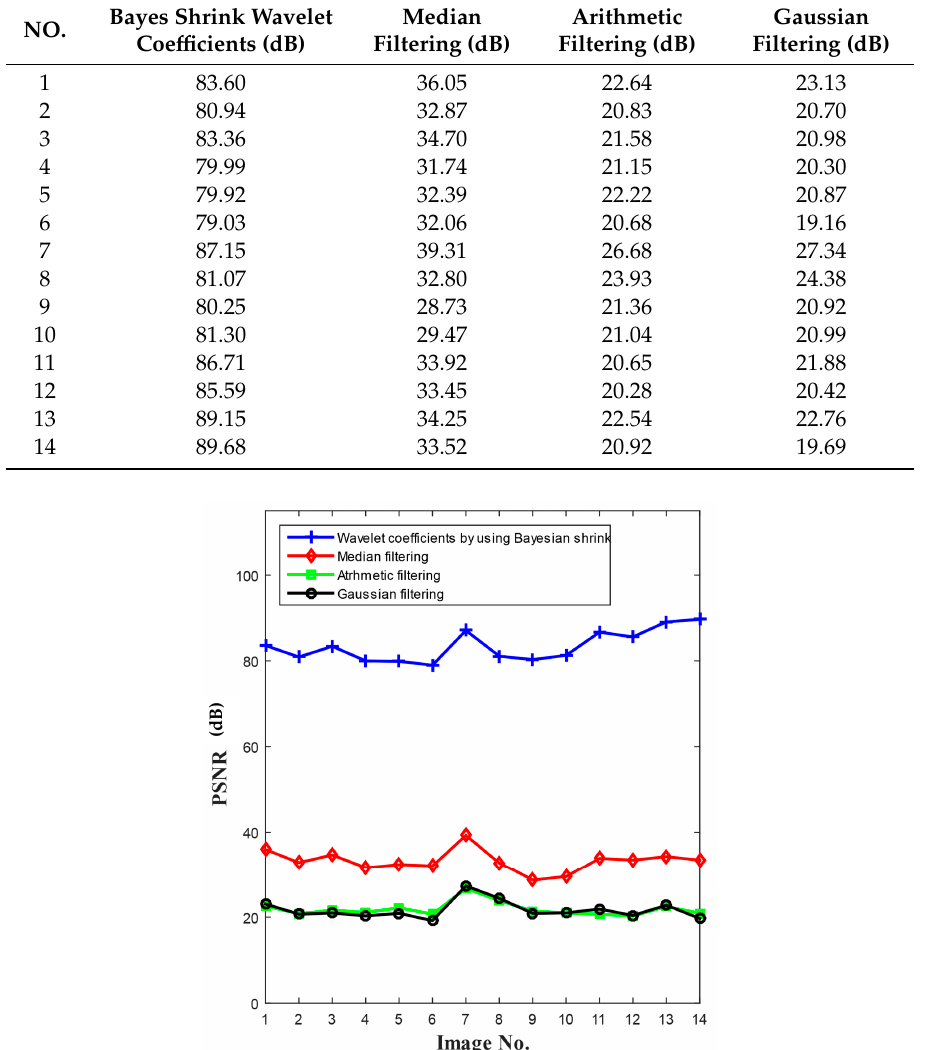
Table 1. The peak signal-to-noise ratio (PSNR) of each de-noising filtering.